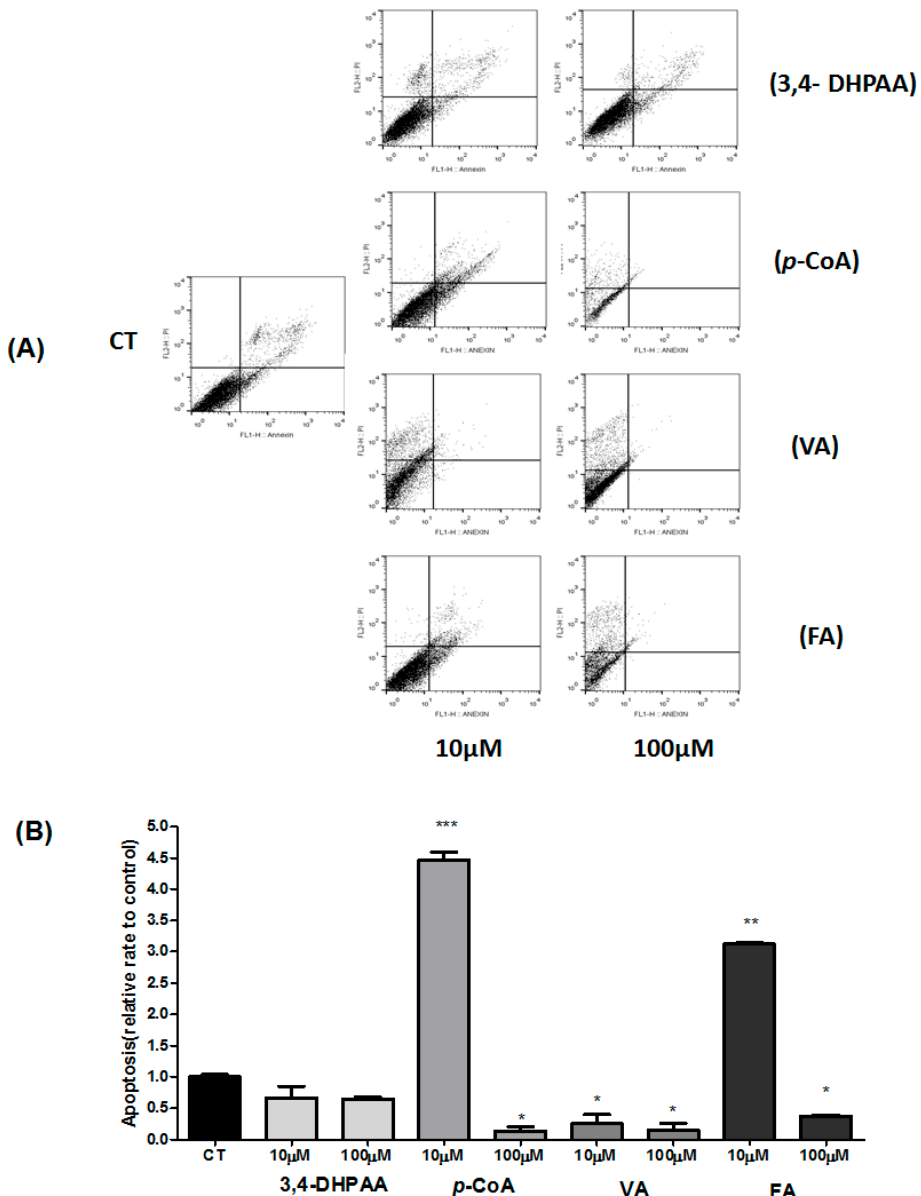
Figure 5. Effect of 3,4-DHPAA, p -CoA, FA and VA on rate of apoptosis in HT-29 cells after 24 h after incubation. Flow cytometry analysis of 3,4-DHPAA, p -CoA, FA and VA are illustrated in ( A )